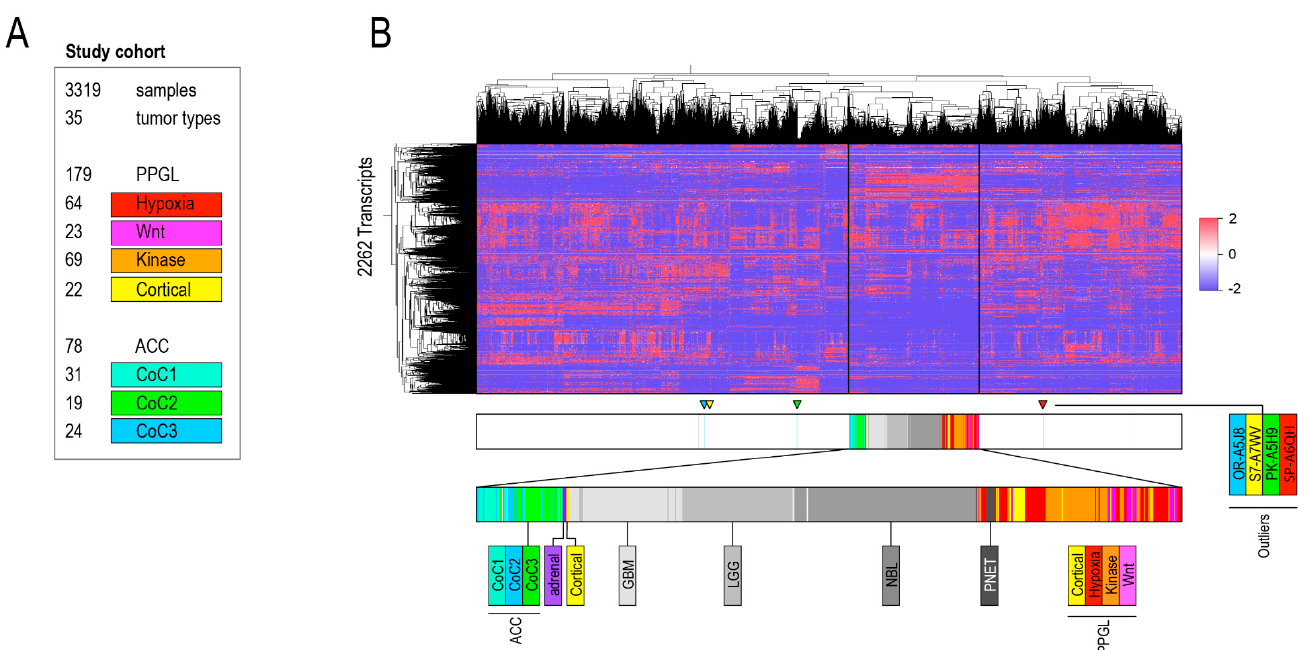
Figure 1. Pan-cancer dataset and transcriptomic classification. ( A ) Pan-cancer analysis dataset and pipeline. Results from bioinformatics pipeline 1. ( B ) Unsupervised hierarchal clustering of RNA-seq data from 3319 TCGA and TARGET samples annotated for cancer type processed by bioinformatics pipeline 1. Abbreviations; ACC, Adrenocortical Carcinoma; GBM, Glioblastoma Multiforme; LGG, Brain Lower Grade Glioma Neuroblastoma; PNET, Pancreatic Neuroendocrine Tumor; PPGL, Pheochromocytoma and Paraganglioma; Cortical, Cortical Admixture PPGL; Hypoxia, Pseudohypoxic PPGL; Kinase; Kinase signaling PPGL and Wnt, wnt-altered PPGL.